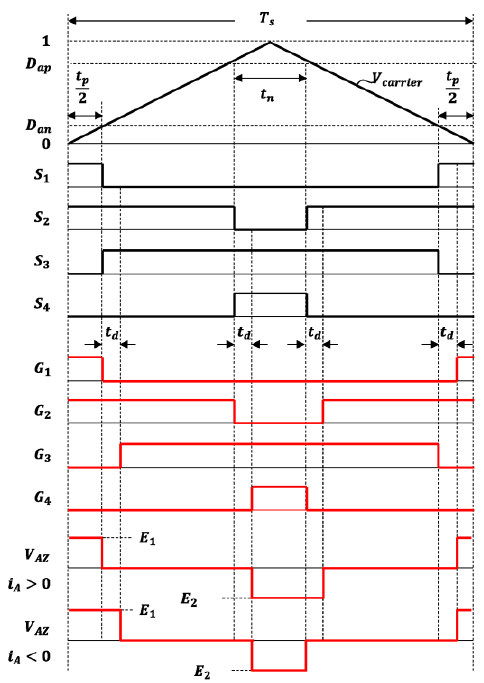
Figure 4. Waveforms of the conventional switching signal with dead-time and the output terminal voltage.